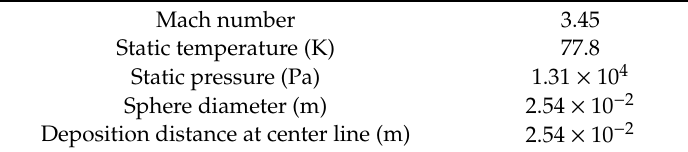
Table 1. Flow conditions in wind tunnel test (calculated).